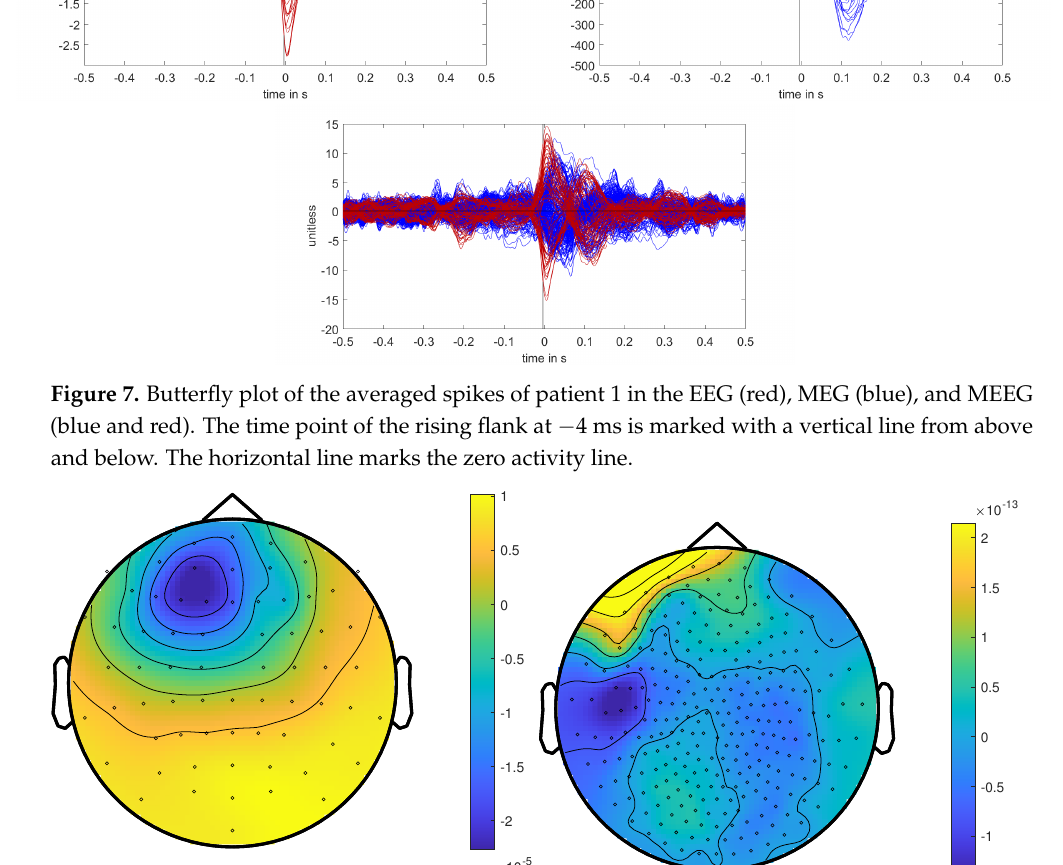
Figure 8. The topographic maps of patient 2, left EEG and right MEG, show the potential and field amplitudes with yellow for positive and blue for negative the sensor level relative to the mean at the time point of the middle of the rising flank at − 4 ms. The sensors are interpolated to a sphere model that represents the